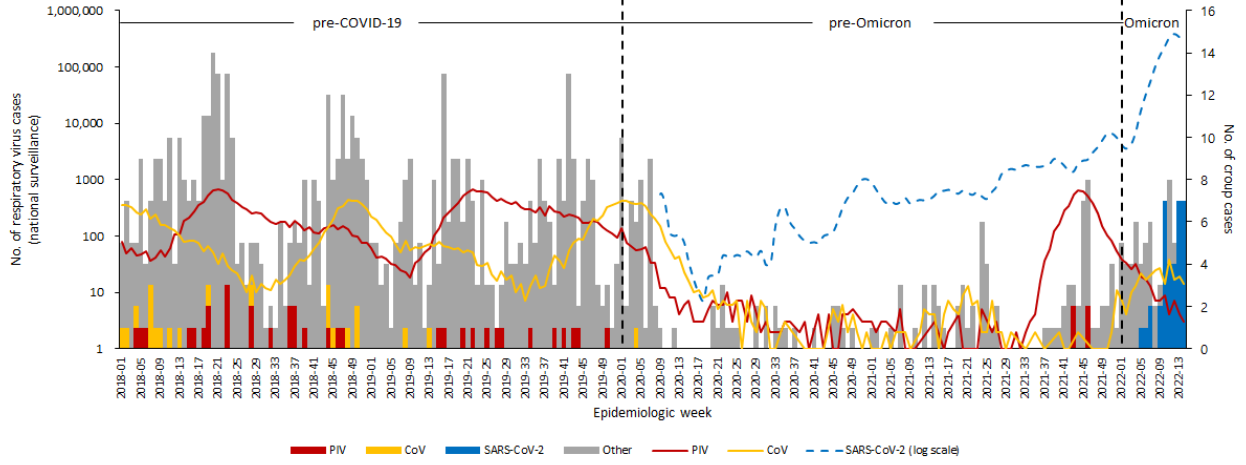
Figure 2. Epidemiologic curve of croup patients from two tertiary hospitals with surveillance data of parainfluenza viruses and coronaviruses, including severe acute respiratory syndrome coronavirus 2 circulating in the community, 2018–2022, South Korea. The broken line indicates circulating respiratory viruses in the community collected from the Laboratory Surveillance Service (Korea Disease Control and Prevention Agency, https://www.kdca.go.kr/ accessed on 12 September 2022). The blue dashed line indicates the mean numbers of weekly SARS-CoV-2 confirmed cases (Korean Ministry of Health and Welfare, http://ncov.mohw.go.kr/en, accessed on 1 August 2022). All lines correspond to the y-axis on the left. Each bar shows croup cases from study sites. Croup cases with detection of parainfluenza virus or coronavirus are correspondently colored. The gray bar indicates croup cases with other or unknown etiology. Each bar corresponds to the y-axis on the right. The left y-axis corresponding to viral surveillance data is presented on a logarithmic scale. COVID-19, coronavirus; PIV, parainfluenza virus; CoV, coronavirus; SARS-CoV-2, severe acute respiratory syndrome coronavirus 2.